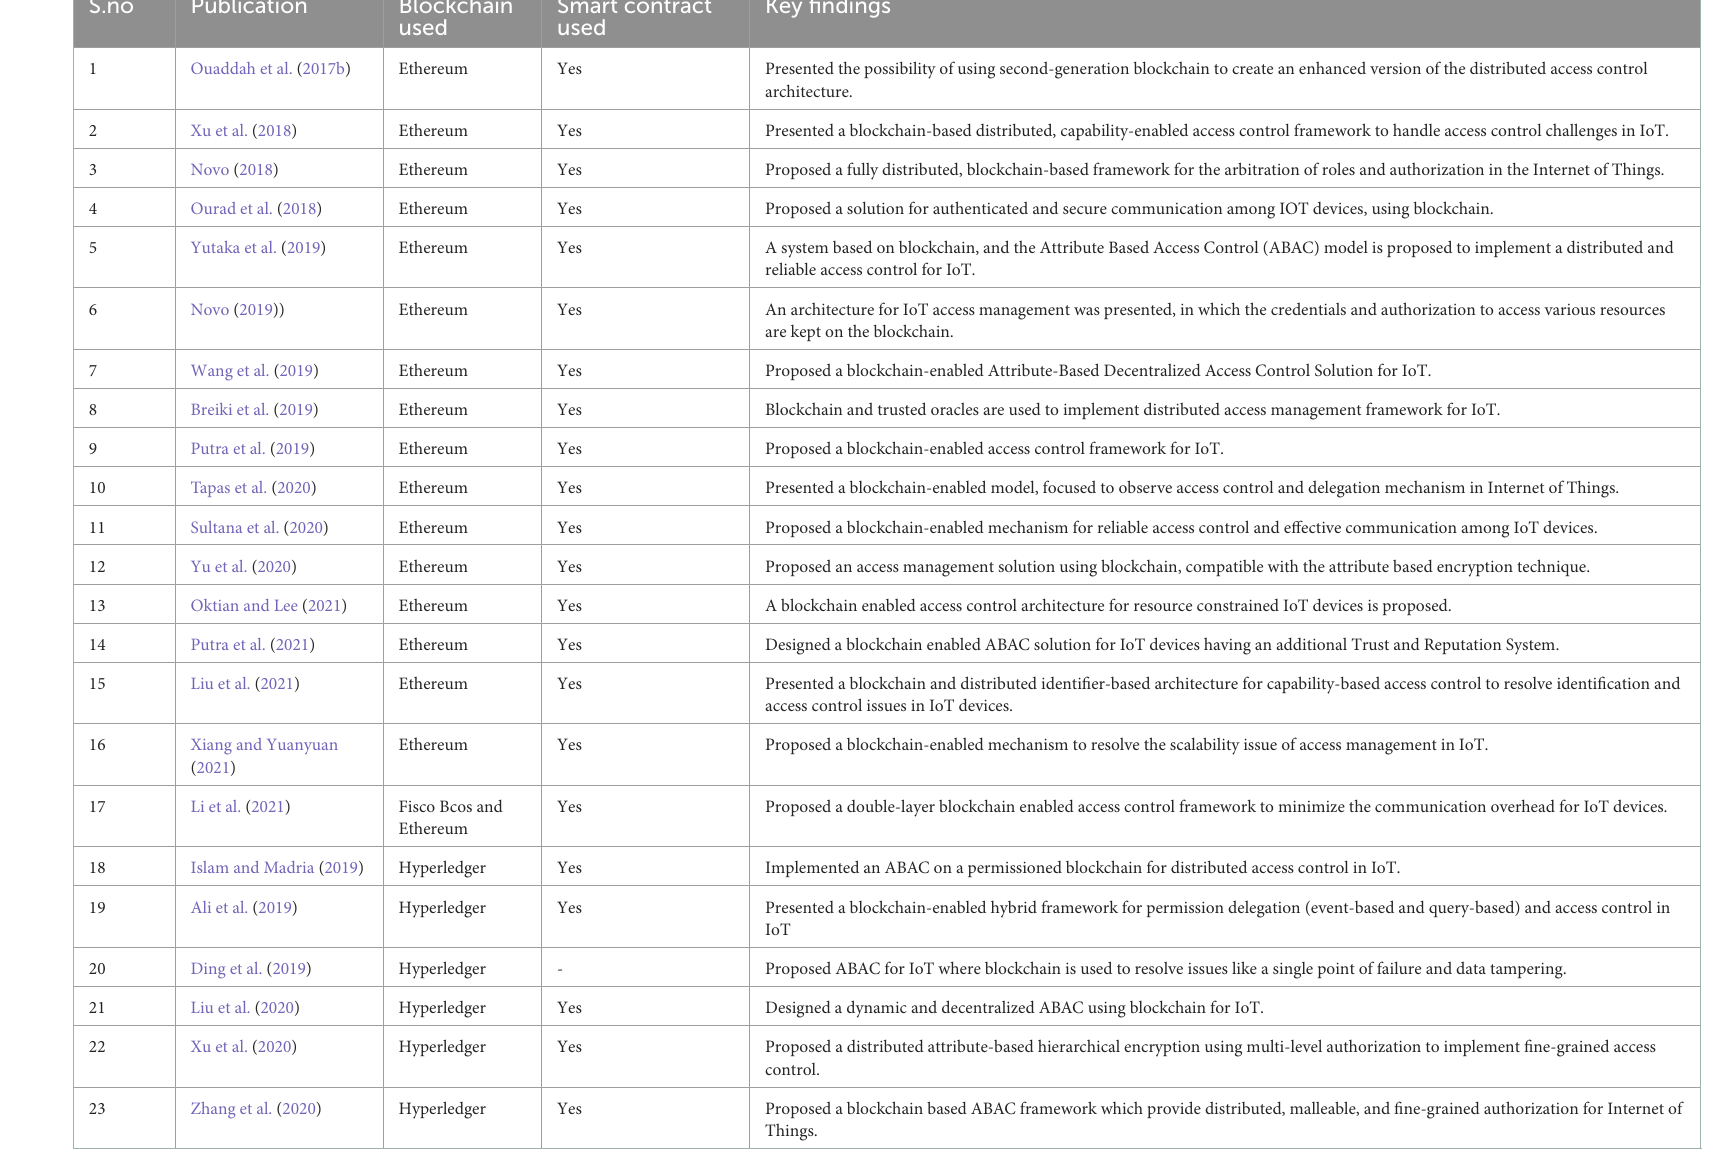
TABLE 3 Key findings and themes of primary